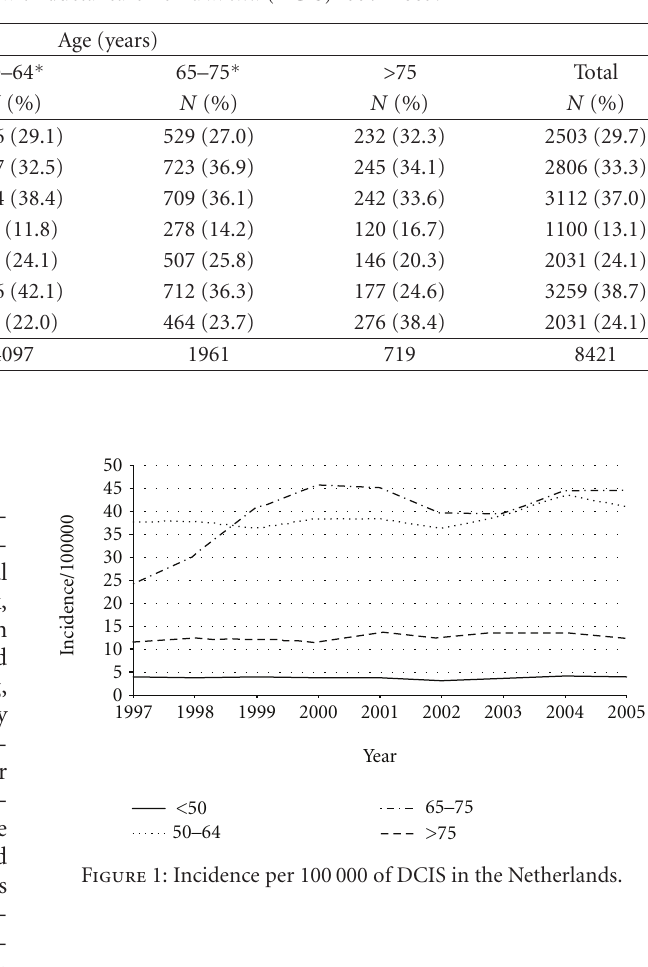
Table 1: Characteristics of the population with ductal carcinoma in situ (DCIS) 1997–2005.